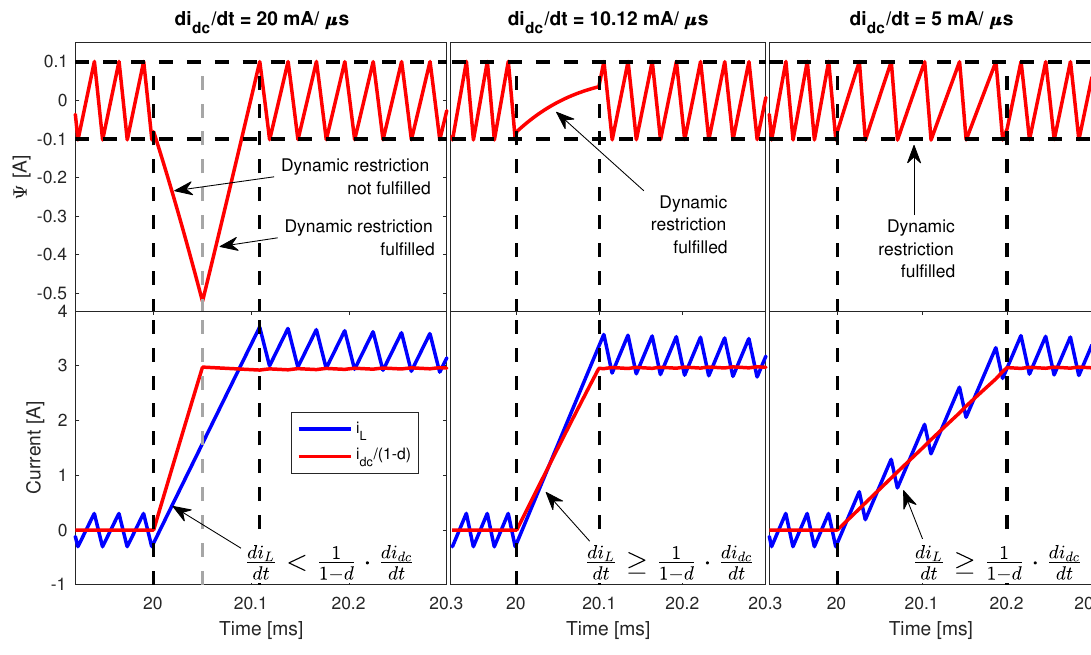
Figure 6. Validation of the inductor design